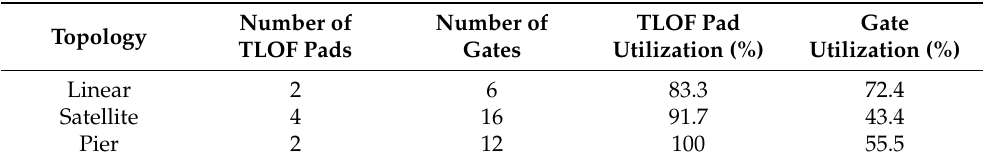
Table 7. Results of each topology for the current Gimpo parking lot space that complies with the FAA’s new regulations.